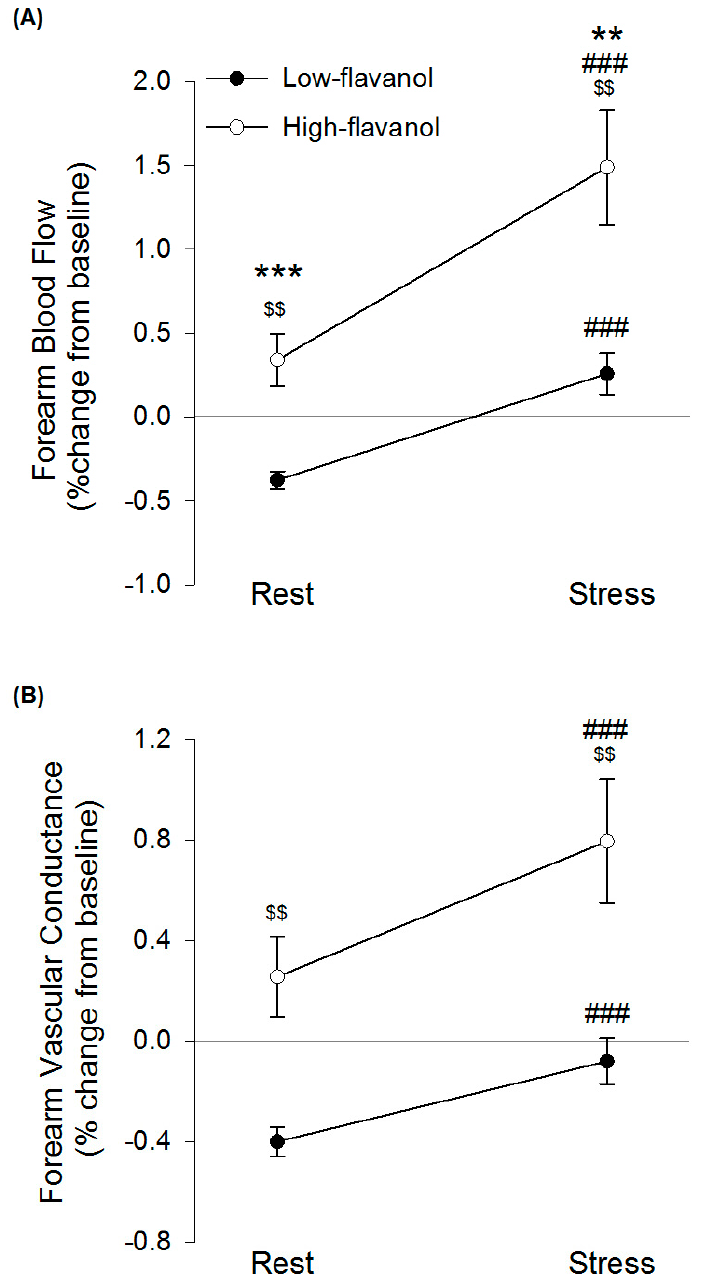
Figure 3. Forearm blood flow ( A ) and Forearm vascular conductance ( B ) following high-flavanol cocoa or low-flavanol cocoa at rest and during stress (8-min PASAT). Values are % change from pre-intervention baseline, and presented as Mean ± SEM. Post-hoc analyses were conducted using Bonferroni’s multiple comparison test. FBF was significantly greater following high-flavanol cocoa compared to low-flavanol cocoa *** during rest ( p < 0.001) and ** during stress ( p < 0.01). ### FBF and FVC were significantly greater during stress compared to rest ( p ’s < 0.001). $$ FBF and FVC were significantly greater following high-flavanol cocoa compared to low-flavanol cocoa ( p ’s < 0.01) (N = 29). FBF, forearm blood flow; FVC, forearm vascular conductance; PASAT, paced-auditory- serial-addition-task; SEM, standard error of